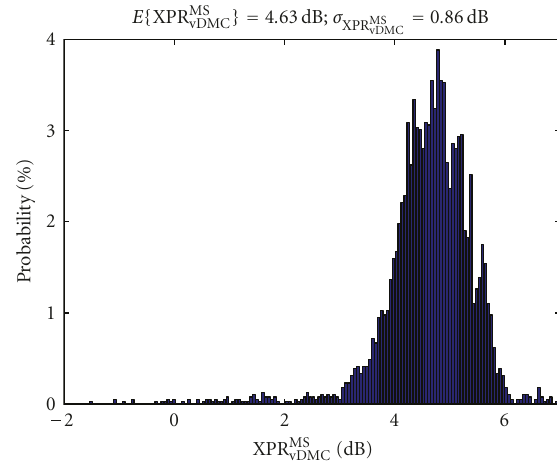
Figure 12: PDF of the XPR MS